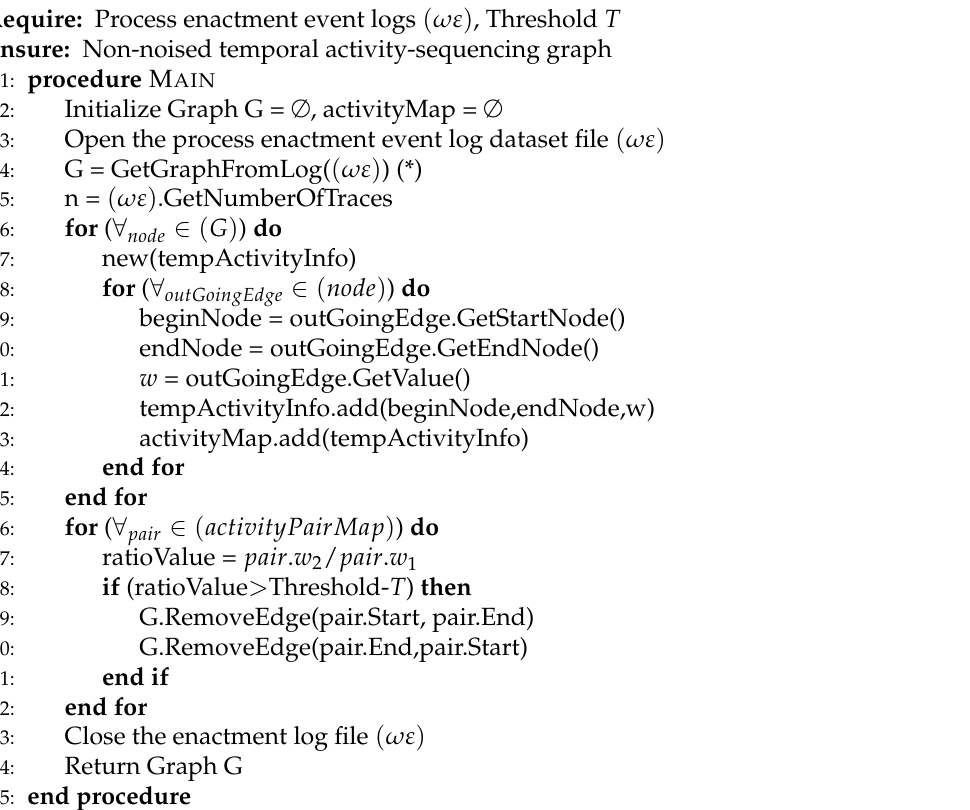
Algorithm 1 The temporal activity-sequencing anomaly detection and removal